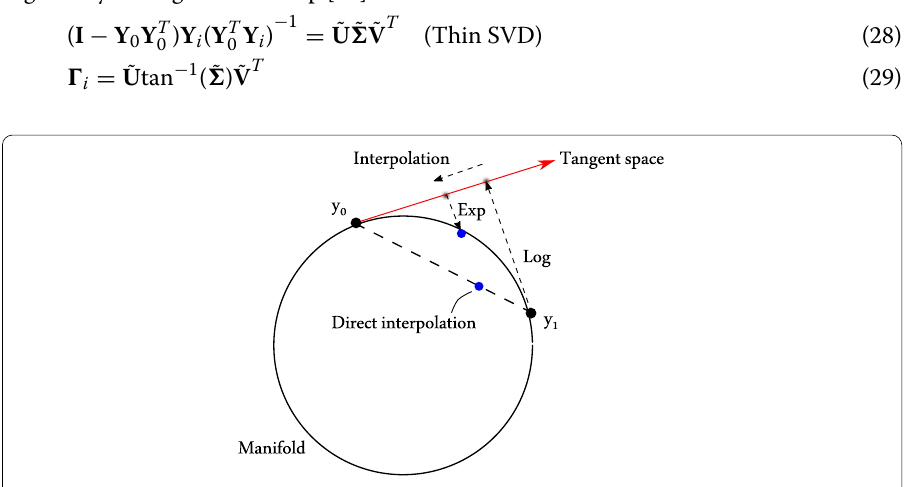
Fig. 1 Manifold-based interpolation vs direct